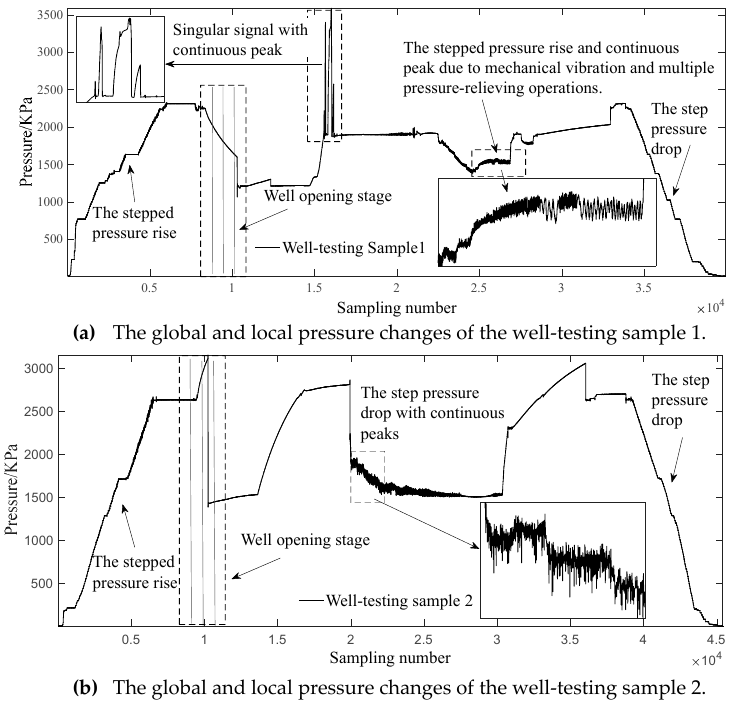
Figure 2. Diagram of oil test data analysis.